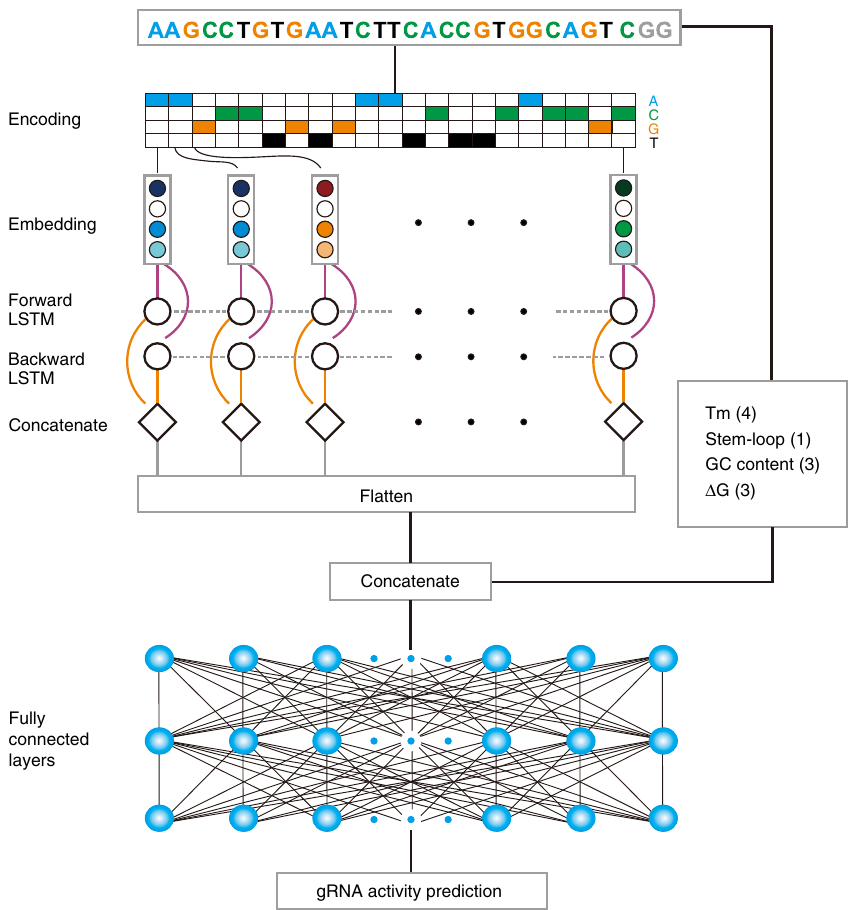
Fig. 6 DeepHF model for gRNA activity prediction. The original gRNA sequence is fi rst encoded and then embedded to get a new representation. This new representation is further processed by a BiLSTM to get the fi nal representation which is then concatenated with hand-crafted features to serve as the input of the fully connected layer to be nonlinearly transformed. Finally, a linear transformation is performed to get the prediction